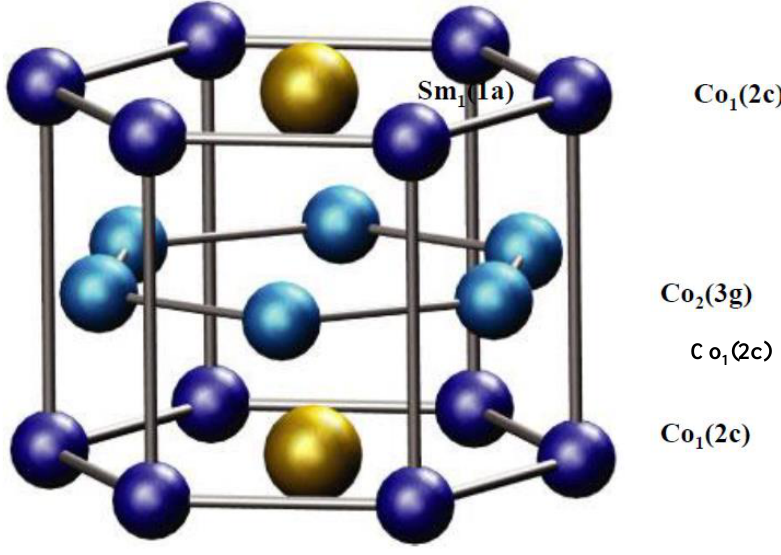
Figure 1. Crystal structure of SmCo 5 . The schematic is taken from ref. [62]. Table 1. Equilibrium formula unit volume, bulk modulus, and its pressure derivative of the YCo 5 compound as functions of the ab initio technique. The unit cell volume is measured at T = 4.1 K. Property SREMTO